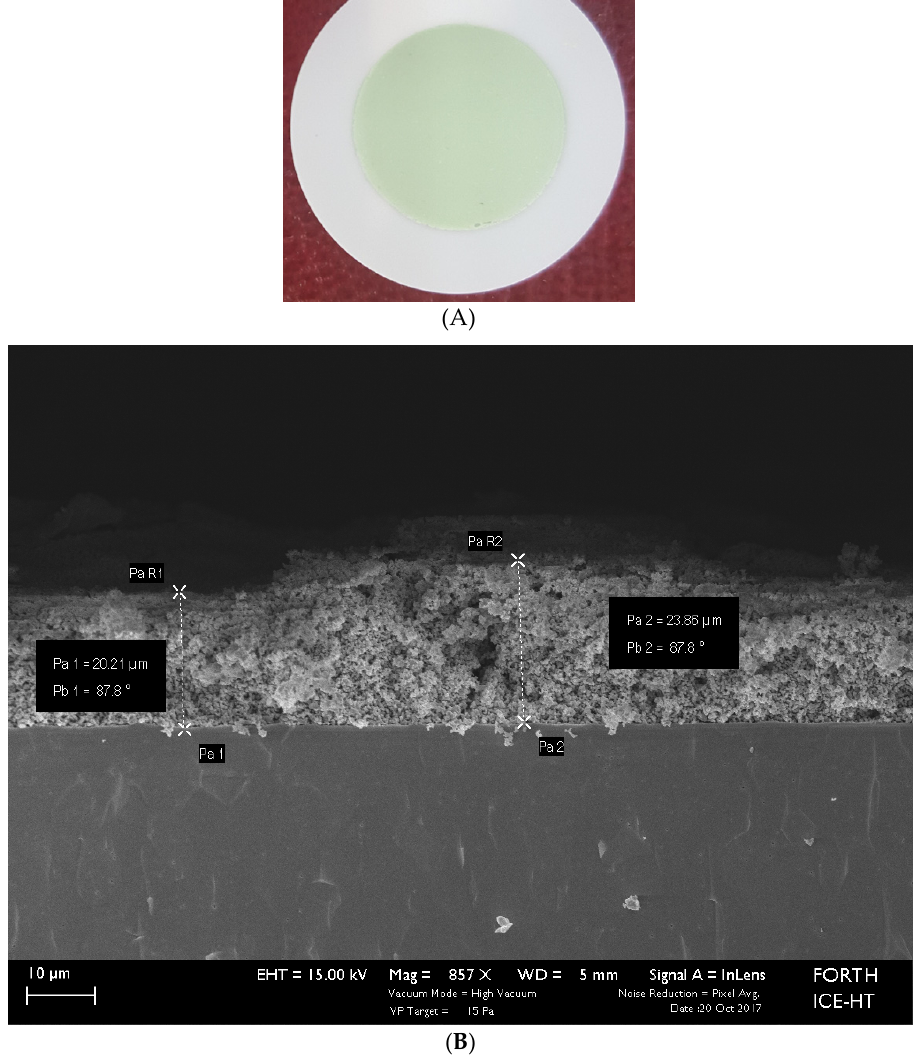
Figure 9. Images of a (half) electrolyte supported cell (ESC) prepared by screen printing: ( A ) NiO/GDC electrode and ( B ) SEM cross section perpendicular to the NiO/GDC//YSZ (half) electrolyte- supported cell.